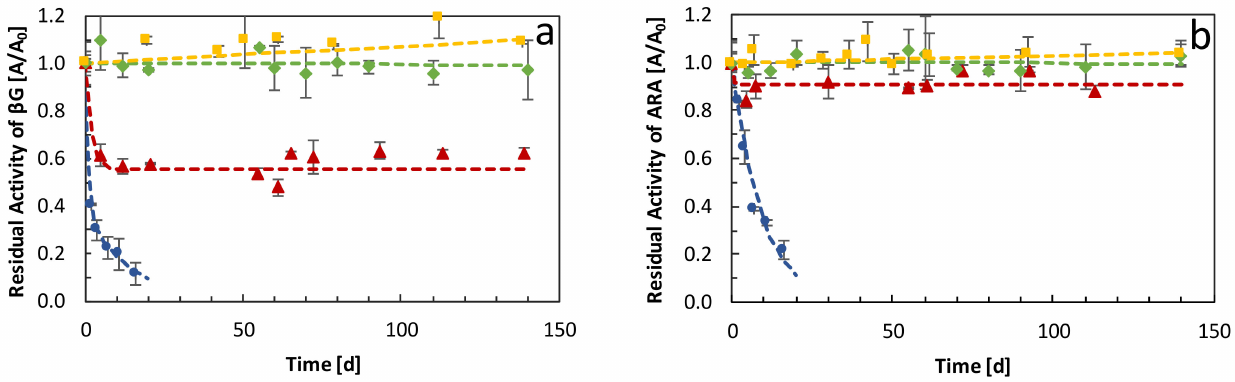
Figure 3. Operational stability of ( ) soluble enzymes, ( ) combi-CLEAs of glycosidases, ( ) combi-CLEAs encap- sulated in alginate beads, and ( ) combi-CLEAs encapsulated in polyvinyl alcohol, carried out in white wine at 16 ◦ C. Results are expressed as residual activity (A/A 0 ) of ( a ) β G and ( b )